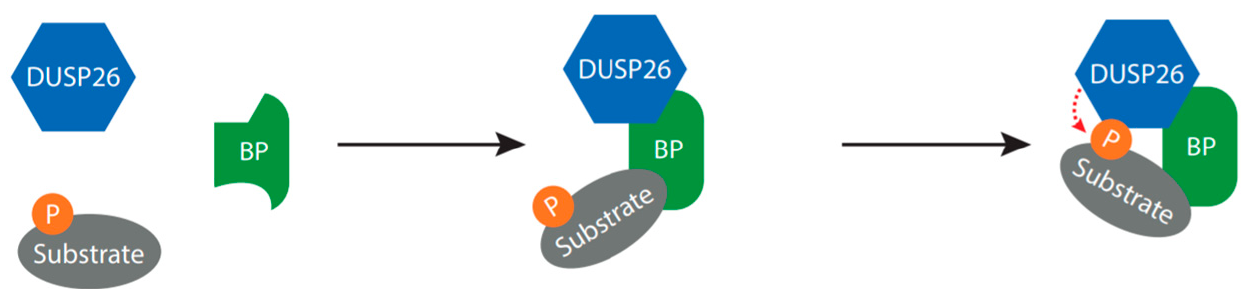
Figure 4. Proposed mechanism for DUSP26-mediated dephosphorylation. The binding partners discussed in this review are all able to bind both DUSP26 and the substrate, suggesting that the binding partner may function as a molecular bridge, required to bring DUSP26 into close proximity to the substrate and/or increase DUSP26 catalytic activity. Abbreviation: BP, binding partner; P, phosphate.